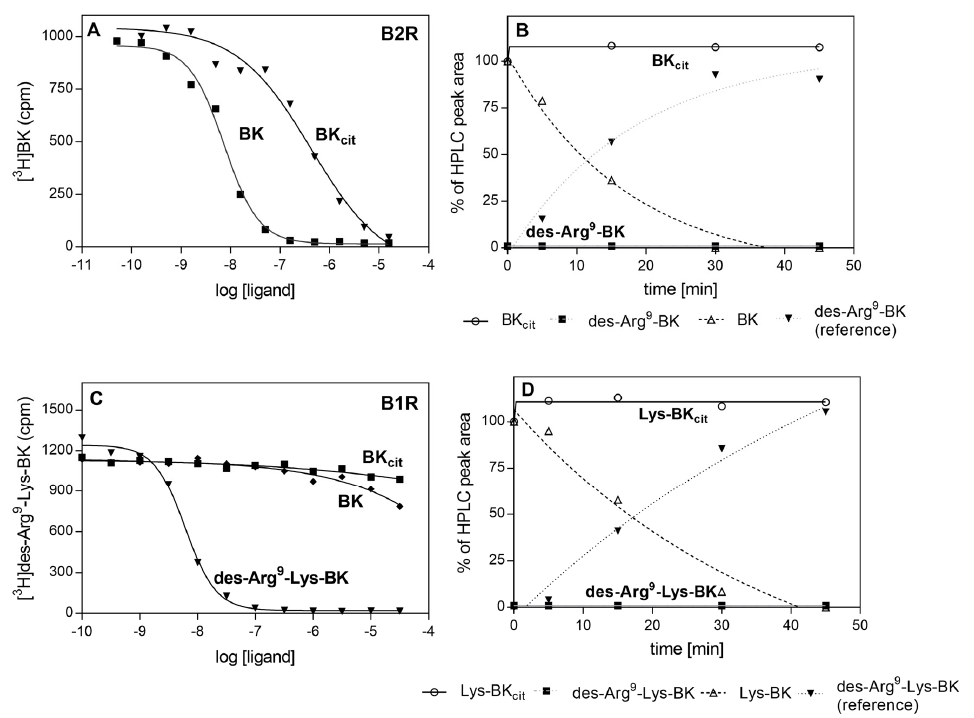
Figure 10. Binding of citrullinated BK to B2R ( A ) or B1R ( C ) and the degradation of BK cit ( B ) and Lys-BK cit ( D ) by CPM. Monolayers of HEK293 cells that overexpressed human B2R or B1R were incubated with a mixture of 2 nM [ 3 H]BK with BK and BK cit ( A ) or 1 nM [ 3 H]des-Arg9-Lys-BK with des-Arg 9 -Lys-BK, BK and BK cit ( C ). The competitors were added at a concentration range of 0.05 nM–50 µ M. For the degradation assay, both BK cit ( B ), Lys-BK cit ( D ), and their reference compounds, were incubated with CPM at a ratio 1:50,000 in 50 mM HEPES bu ff er, pH 7.0 at 37 ◦ C. Products of the enzymatic reactions formed in the di ff erent time intervals were separated by HPLC.